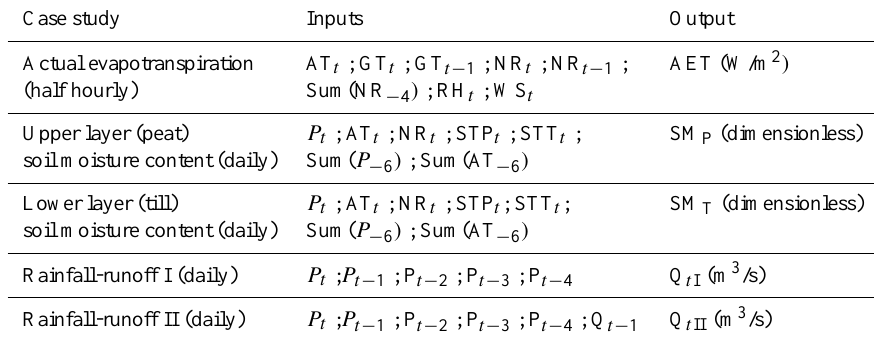
Table 4. Inputs and outputs of all case studies.